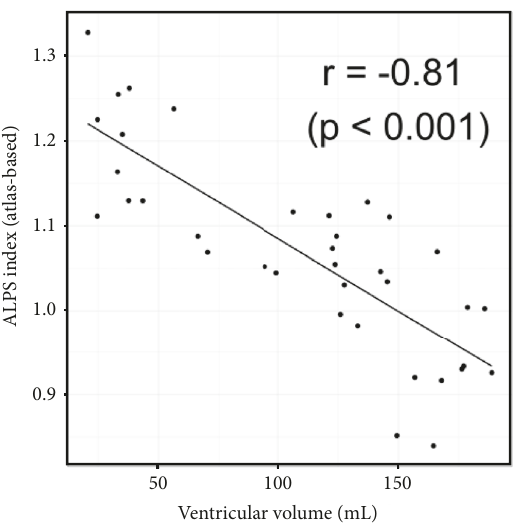
Figure 6: Scatter plot shows correlation between atlas-based ALPS index and supratentorial ventricular volume. There was strong correlation between them (r = -0.81, p <